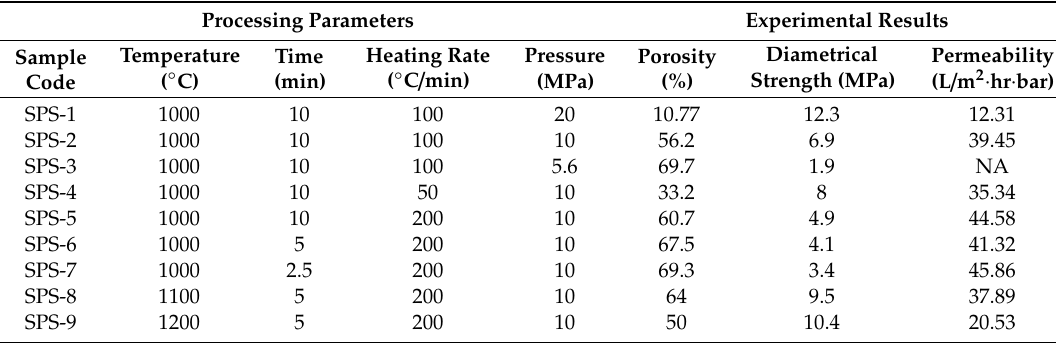
Table 1. Spark plasma sintering (SPS) processing parameters, porosity, diametrical strength, and permeability of SPS